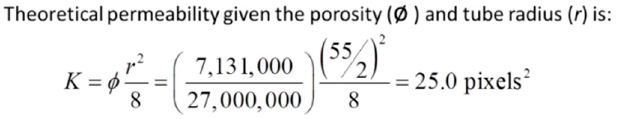
Figure 6. Sample model pore structure used to validate the Stokes permeability solver.